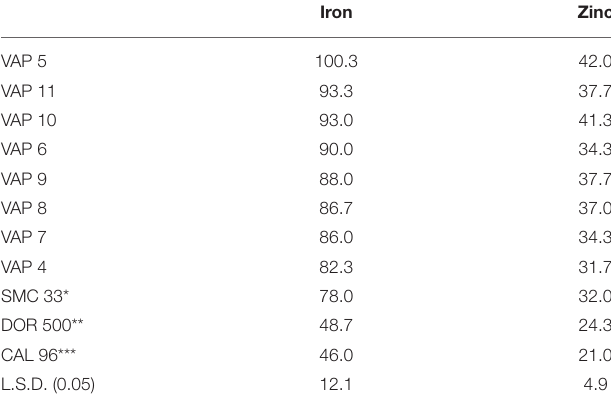
TABLE 2 | Iron values (mg kg − 1 ) of interspecific lines of bush growth habit derived from the cross [(INB 834 × G 40264) F1 × INB 841] F1 × SMR 139 as measured by XRF